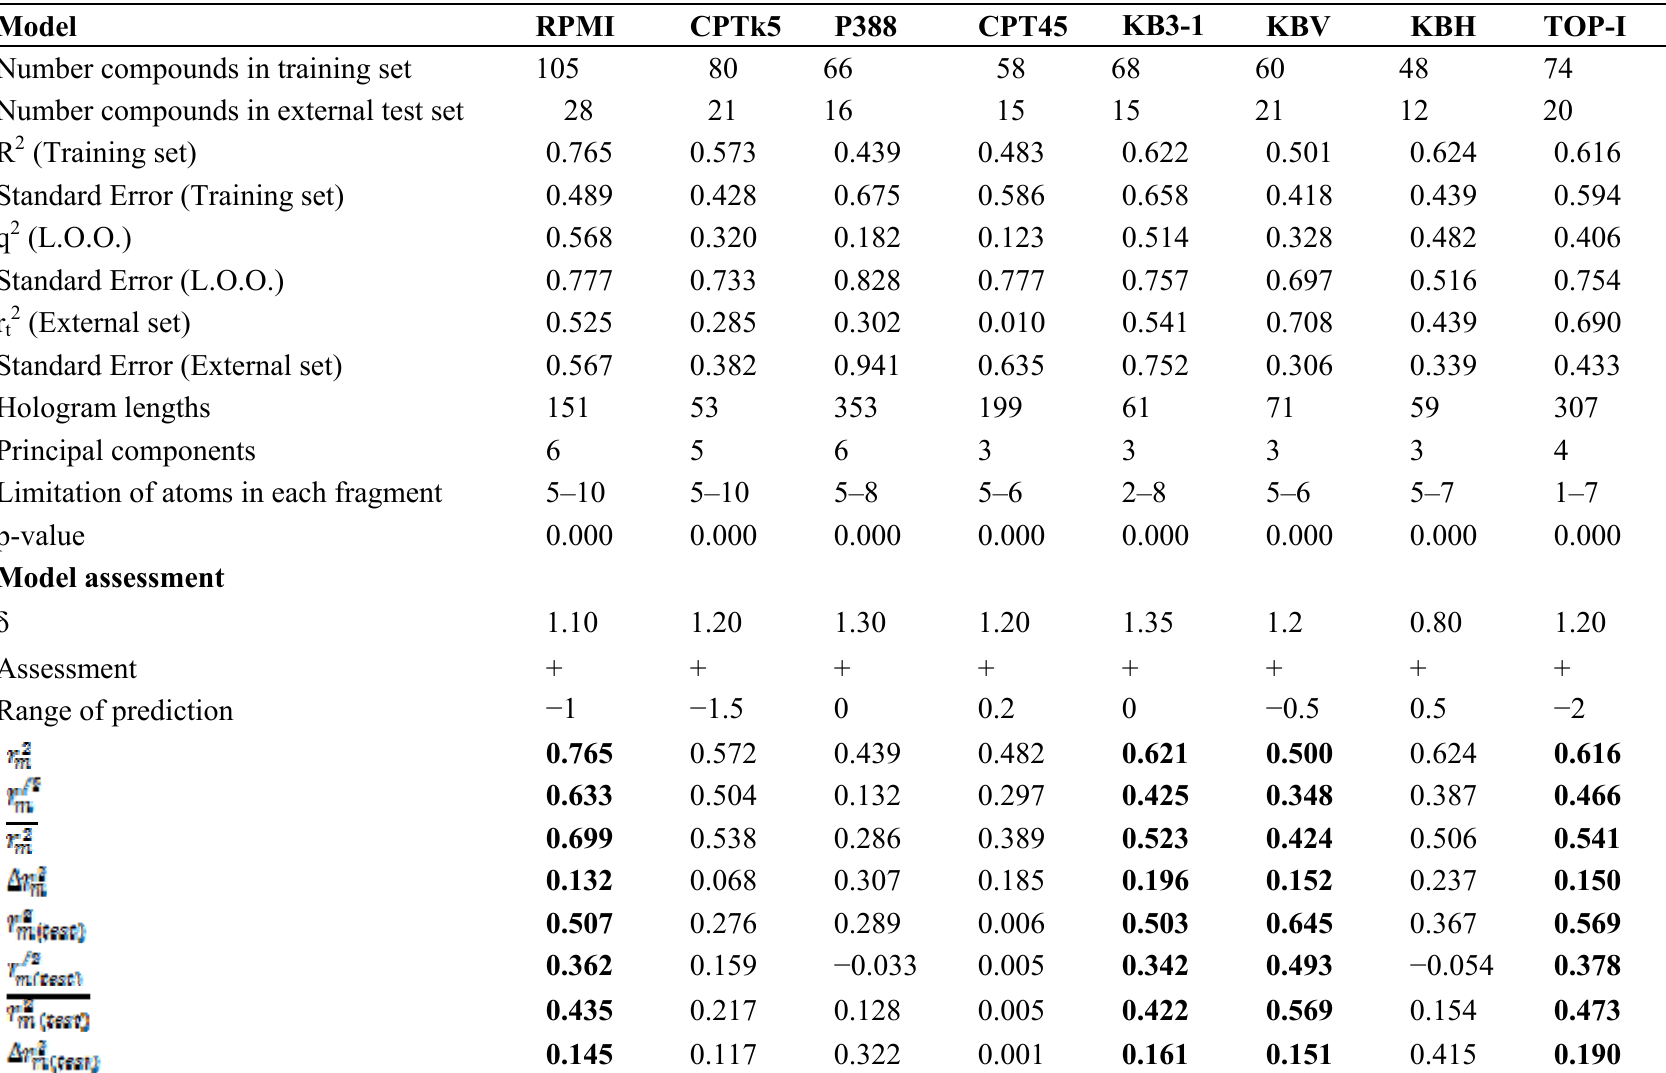
Table 4. Results of